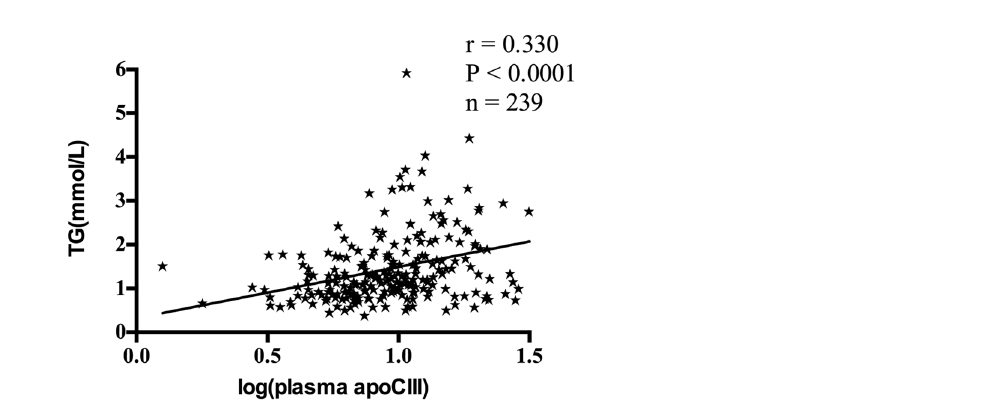
Figure 3. The correlation between plasma apoCIII (log transformed) and triglyceride in all the subjects (n = 239). ApoCIII indicates apolipoprotein CIII; TG,